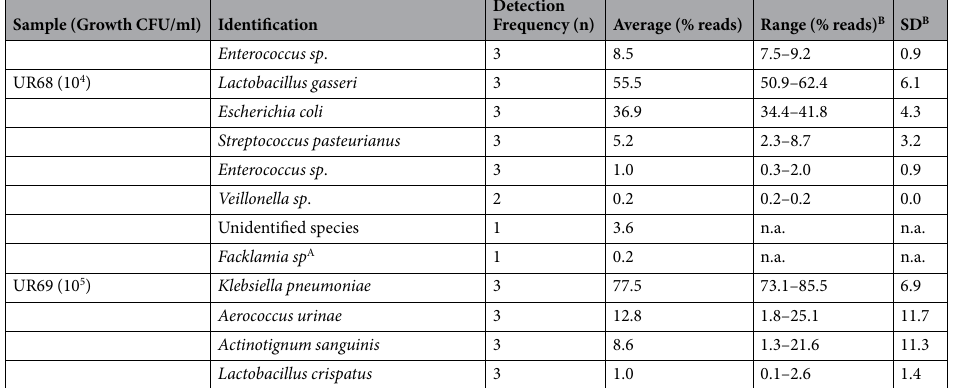
Table 4. Reproducibility of NGS of the 16S-23S region. A Bacterial microorganism previously reported as contamination of DNA extraction kits, PCR and other laboratory reagents 10 . B n.a., not